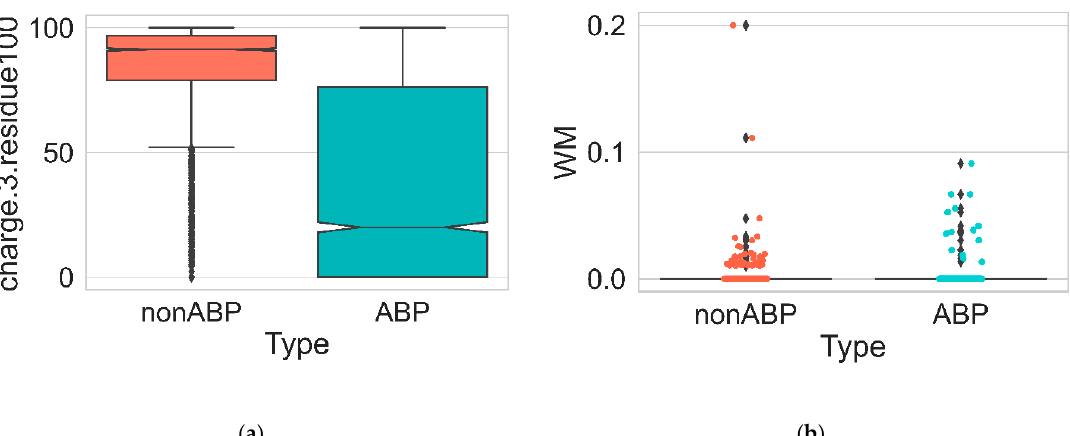
Figure 1. ( a ) Two box plots showing values for an important feature for antibacterial peptides (ABPs) and non-ABPs. The median value (indentations in box) for non-ABPs is ~90, while for ABPs it is close to 25. Importantly, the boxes do not overlap, demonstrating that for >50% of the peptides, the feature values differ. ( b ) For a feature of low importance, the distributions are